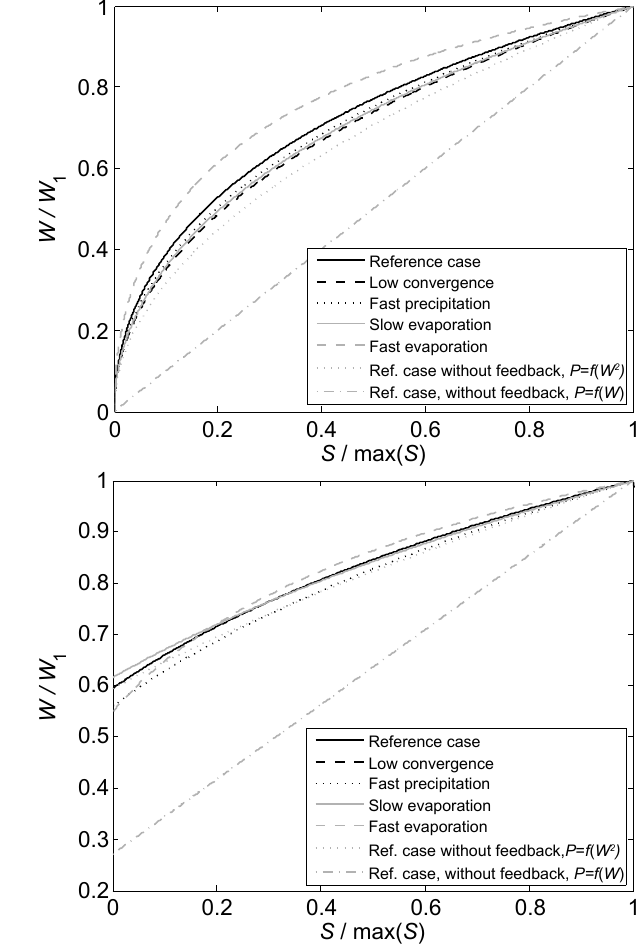
Fig. 3. Top: Point scale fluxes along x corresponding to the two regimes of Fig. 2; top; W 0 = 1.0, bottom: W 0 = 0 . 5; F a stands for the advective flux, F I for the lateral influx. Note that for W 0 = 1.0, E T = 0, see Eq. (3).